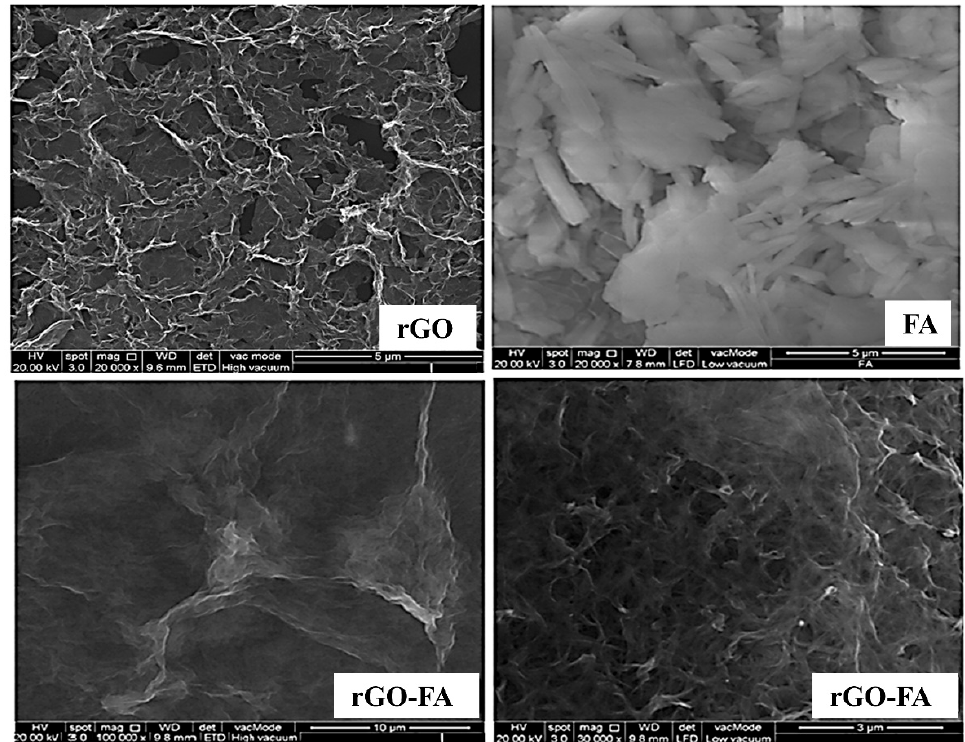
Figure 4. SEM images of rGO, FA, and rGO-FA at lower (left) and higher (right) magnifications.